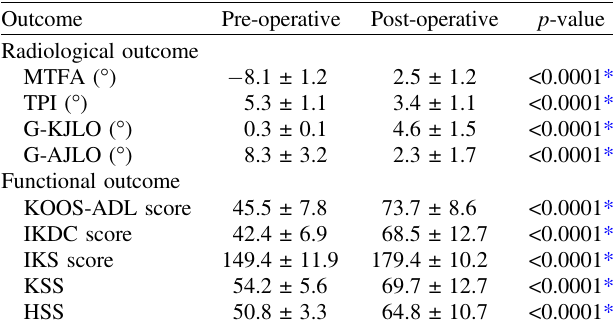
Table 1. Comparison of various outcome measures before and after